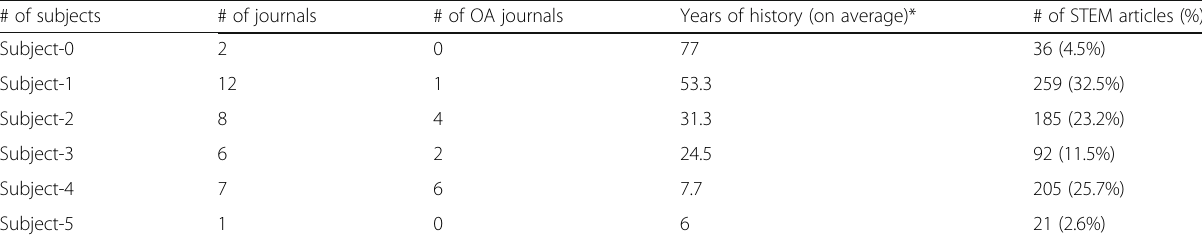
Table 2 Information about journals in different subject categories